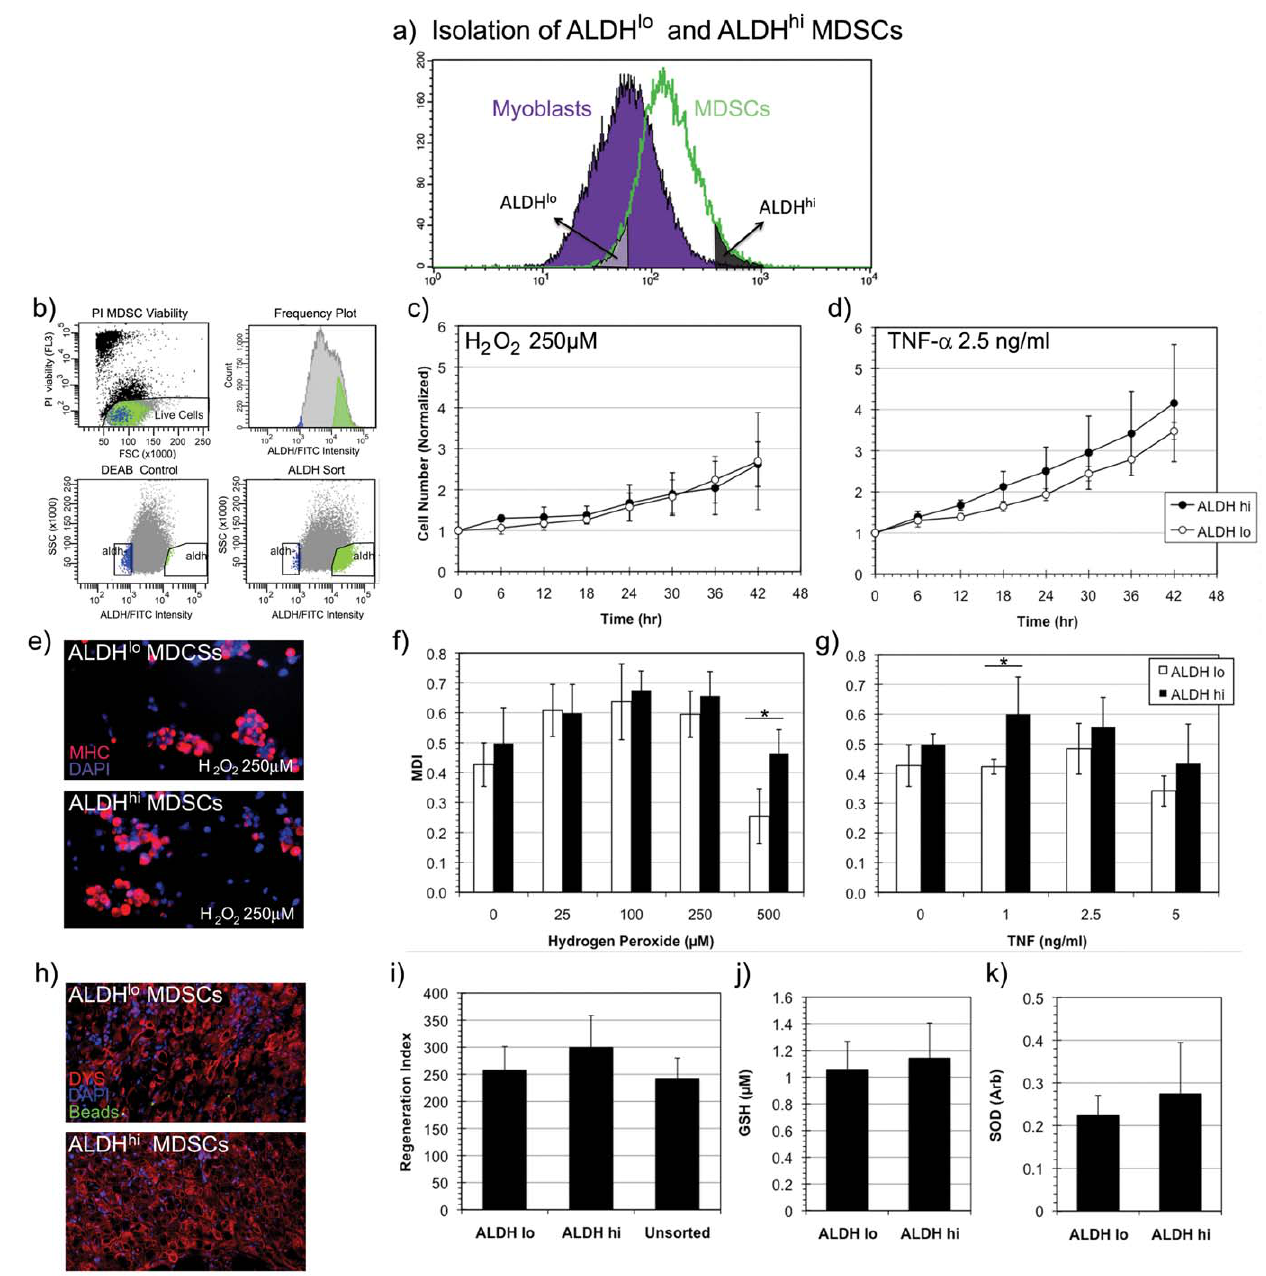
Figure 5. Isolation and stress resistance capacity of ALDH hi MDSCs. (a) A schematic of the isolation of ALDH lo and ALDH hi subpopulations of MDSCs is depicted here. (b) As discussed previously, ALDH lo and ALDH hi MDSCs were isolated, by excluding propidium iodide stained dead cells, and forming appropriate ALDH gates using DEAB inhibited controls. (c, d) No statistically significant difference in proliferative capacity between ALDH lo and ALDH hi MDSCs in oxidative stress (H 2 O 2 , 250 m M) or in inflammatory stress (TNF- a , 2.5 ng/ml) was observed (n=9). (e) ALDH sorted MDSCs underwent myogenic differentiation in oxidative stress (H2O2, 250 m M) by expressing myosin heavy chain (MHC) and fusing into MHC + clusters (red) rather than fusiform myotubes. (f, g) Significant differences in myogenic differentiation indices (MDI) were not observed in ALDH hi MDSCs compared to ALDH lo MDSCs except at one very high oxidative stress (H 2 O 2 , 500 m M) and at an intermediate inflammatory stress level (TNF- a , 1 ng/ml) (n=9, * indicates p , 0.05). (h) Robust engraftment of ALDH lo and ALDH hi MDSCs was observed following intramuscular injection into the gastrocnemius of mdx mice. Dystrophin (DYS) positive myofibers (stained in red) indicate transplanted MDSC myofiber generation or fusion with a host myofiber. (i) No statistically significant differences in regeneration index were observed in ALDH hi transplanted mice compared to those injected with ALDH lo and unsorted MDSCs (n=3). (j, k) Measurements of intracellular antioxidant levels in terms of glutathione (GSH) and superoxide dismutase (SOD) levels yielded no statistically significant differences between ALDH lo and ALDH hi MDSCs (n=3).